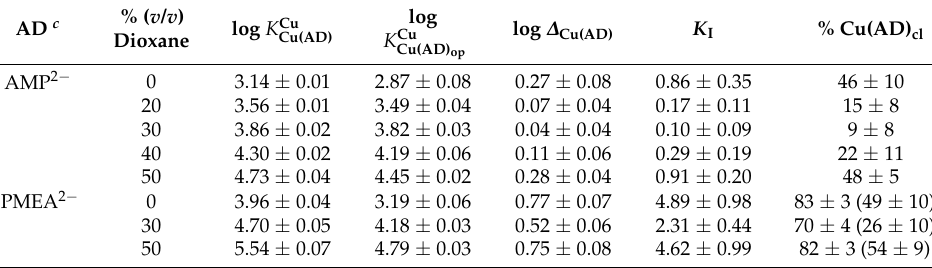
Table 11. Extent of chelate formation involving Cu 2+ and the adenine residue (AD) of AMP 2 − and PMEA 2 − (analogous to Equation (14)) in aqueous solution and in water containing varying percentages ( v / v ) of 1,4-dioxane at 25 ◦ C and I = 0.1 M (NaNO 3 ). The alterations are quantified via log ∆ Cu(AMP) and compared with log ∆ Cu(PMEA) (Equation (12)). These data are based on the stability of the Cu(AMP) and Cu(PMEA) complexes (analogous to Equation (8)) a,b . % ( v / v ) log AD c log ∆ Cu(AD) K I % Cu(AD) cl log K Cu Cu(AD) K Cu Dioxane Cu(AD) op AMP 2 −